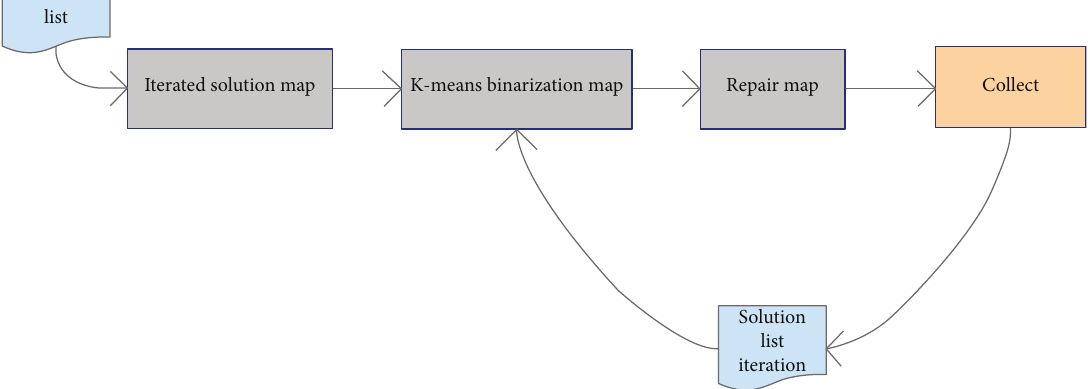
Figure 3: Flow chart of Spark binary cuckoo search algorithm.